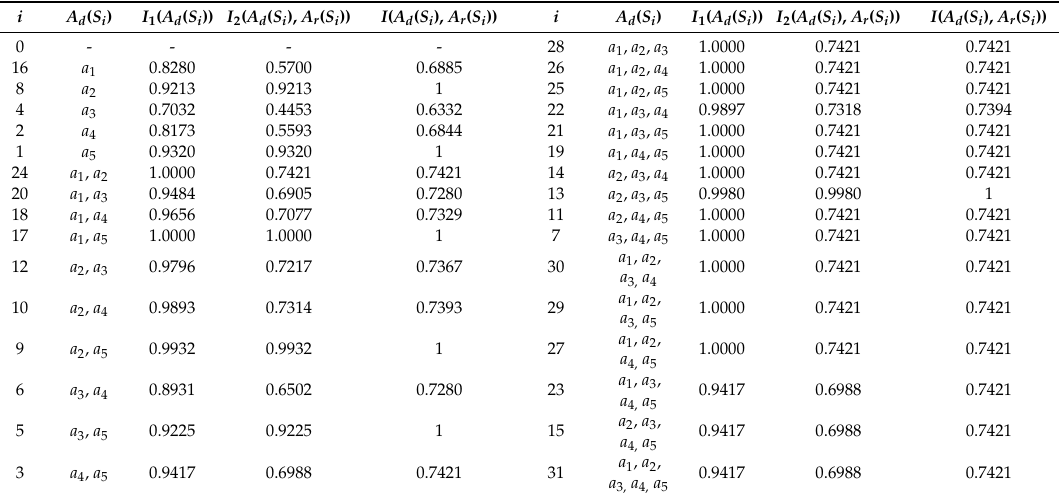
Table 5. All the component importance from Figure 2.